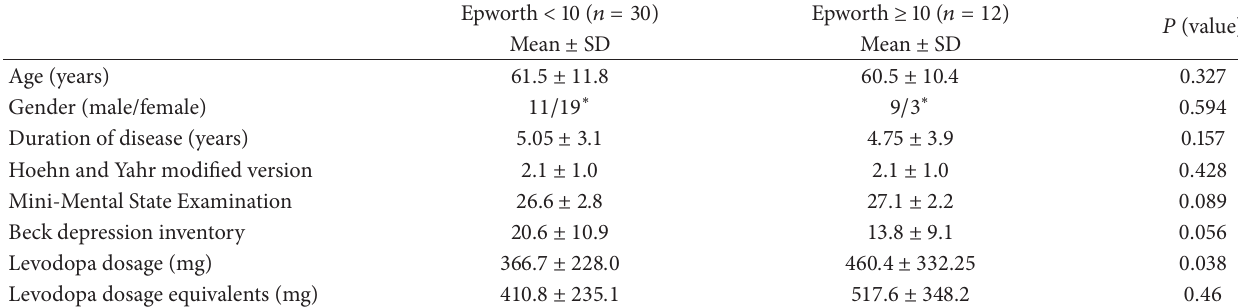
Table 2: Comparison of variables scores according to excessive daytime sleepiness.